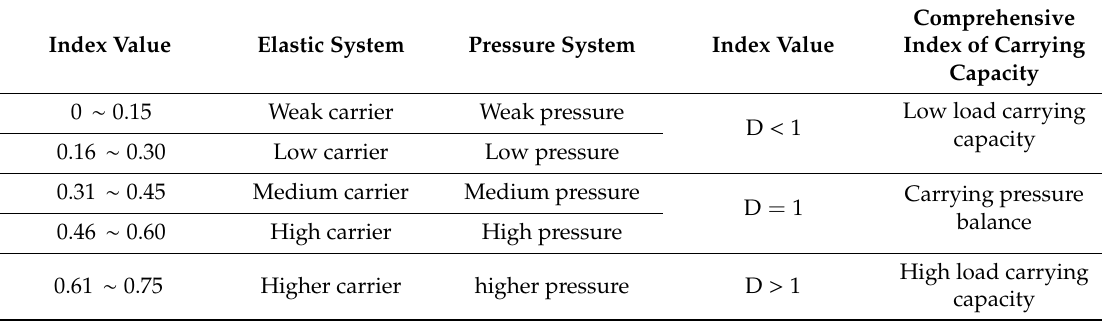
Table 2. Classification evaluation criteria for urban ecological carrying